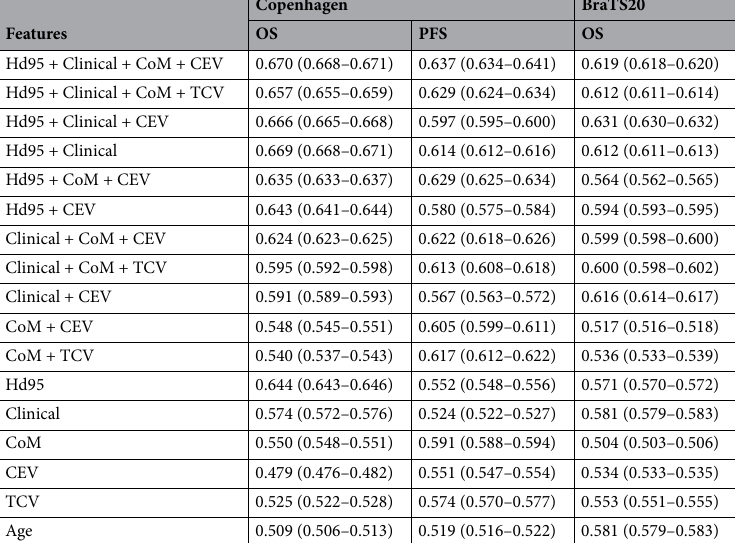
Table 2. Prediction performance measured with the C-index for models trained on several different sets of features. The first two columns show results for OS and PFS prediction on the Copenhagen post-operative dataset, whereas the last column contains OS prediction performance on the BraTS20 pre-operative dataset. Note that the clinical features for the Copenhagen dataset include age, performance status, and MGMT methylation, while the available clinical features for the BraTS dataset consist only of age. Including the proposed Hausdorff (Hd95) features in the survival model provides an improvement in prediction performance over models that only consider conventional clinical features, tumor size and